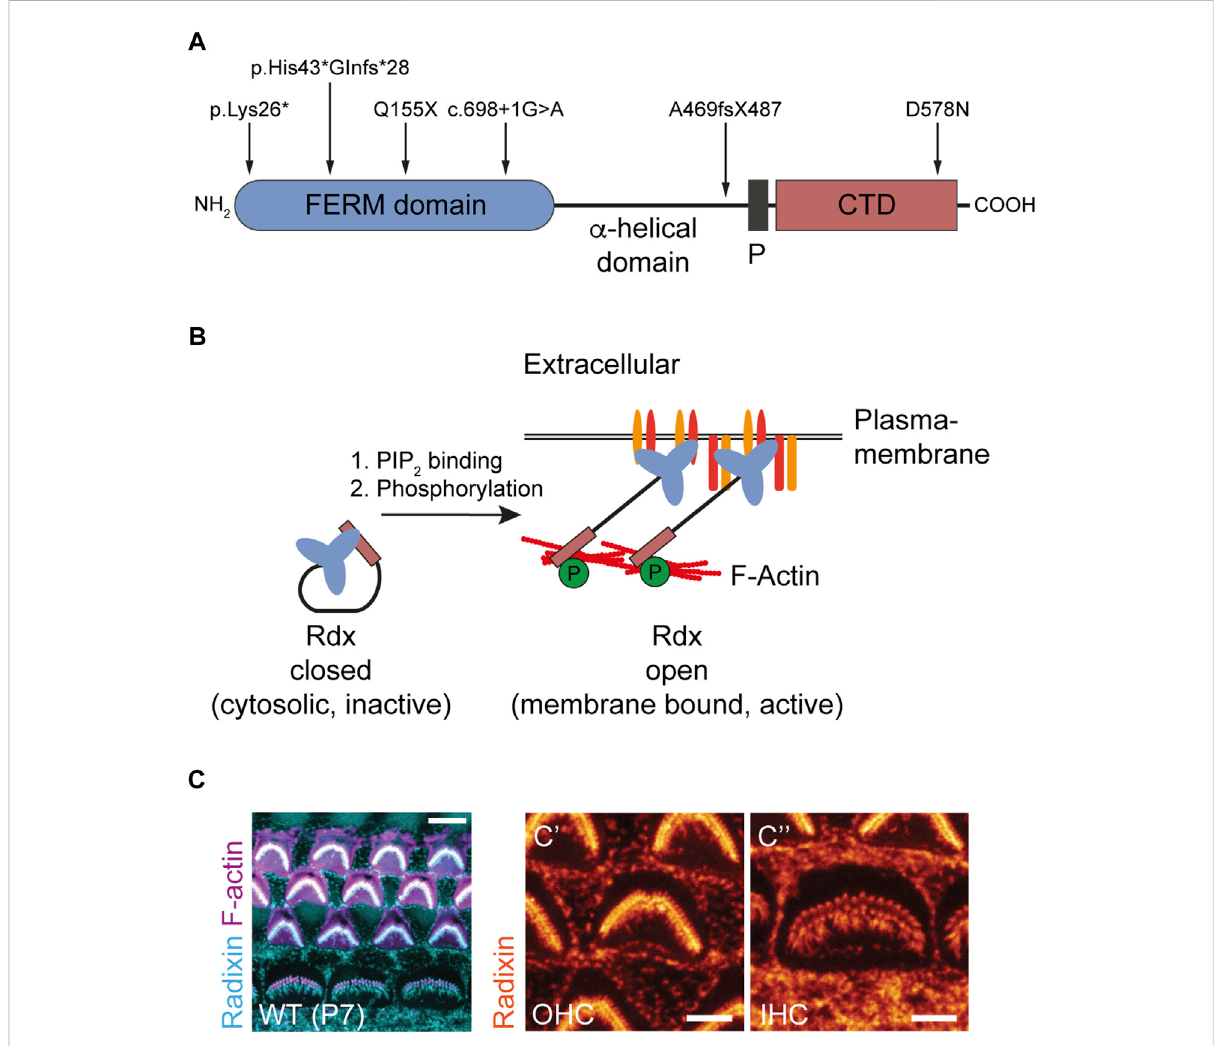
Radixin is associated with hearing loss and is expressed in the stereocilia of auditory hair cells. (A) Domain structure of Rdx indicating human mutations known to cause DFNB24 hearing loss. Erythrocyte Band 4.1 protein-, Ezrin-, Radixin-, Moesin-(FERM) domain harboring the PIP 2 binding site. Proline-rich domain (P). C-terminal domain (CTD) harboring the F-actin binding site. (B) Schematic illustration of Rdx activation. Rdx exists in twoconformationalstates.Theclosed,inactiveformismainlylocalizedtothecytosol.BindingofitsC-terminalFERMdomaintoPIP 2 withinthe plasmamembraneandsubsequentphosphorylationwithinitsC-terminalF-actinbindingdomainactivatestheprotein.Initsopenconformation,Rdx acts as a crosslinker between the plasma membrane, integral and associated membrane proteins, and the cortical F-actin cytoskeleton. (C) Representative confocal microscopy maximum projection of mouse cochlear hair cell stereocilia stained for Rdx (blue) and F-actin (purple) using phalloidin-Atto647N at postnatal day 7 (P7). The magni fi cation to the right illustrates Rdx expression (orange) in hair bundles of (C ′ ) outer hair cells (OHCs) and (C´´) inner hair cells (IHCs) as well as microvilli at the apical surface of surrounding cells.